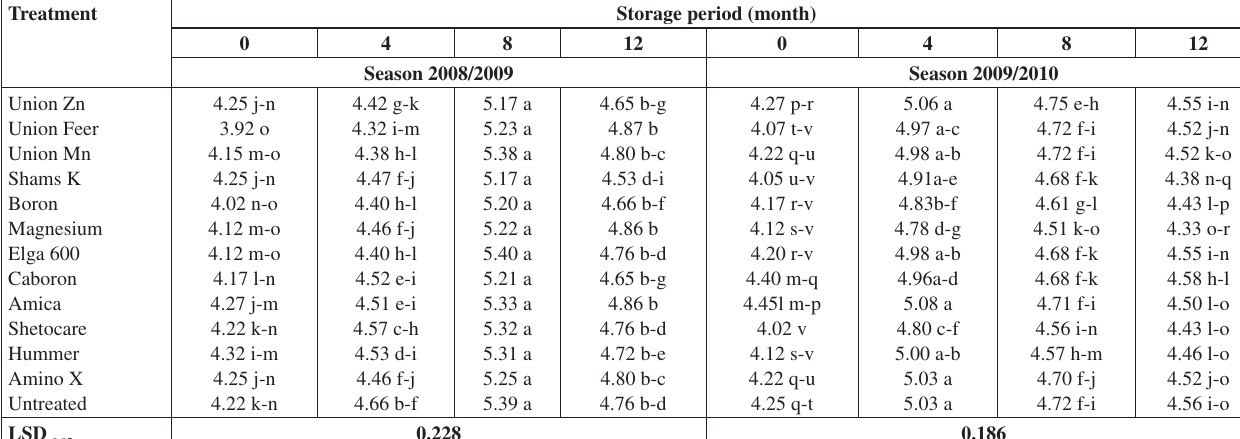
Table 13: Effect of the interaction between storage period and foliar application with commercial compounds on water content (%) of onion seeds